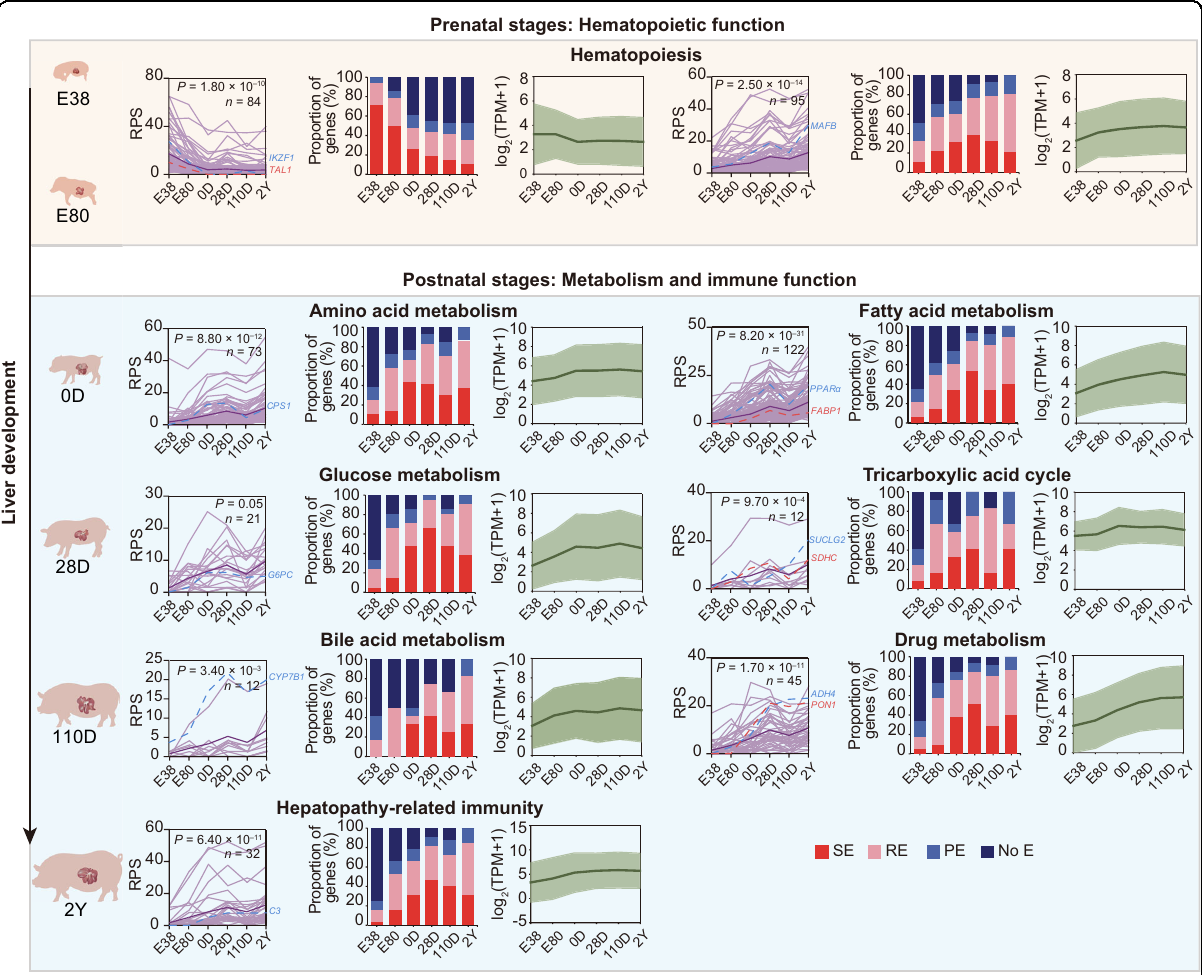
Fig. 5 Rewiring of PEIs associated with shifts in core liver functions during development. The predominant RPS patterns across developmental stages were separately identi fi ed for eight a priori gene sets associated with core liver functions at prenatal (hematopoiesis) and postnatal stages (metabolism of amino acid, fatty acid, glucose, bile acid, and drug; tricarboxylic acid cycle; and immunity) (Supplementary Data S2) using STEM. The bold lines in the left panels represent the mean RPS, and the thin lines represent the RPS of each gene in the relevant cluster during development. FDR-corrected P -values were obtained from multiple hypothesis testing. For each RPS cluster, the proportions of genes that interacted with differently active enhancers (activity ranking: SE > RE > PE) at each stage (middle) and the gene expression changes (right) were consistent with the dynamic RPS (left). Representative functional genes are labelled on the